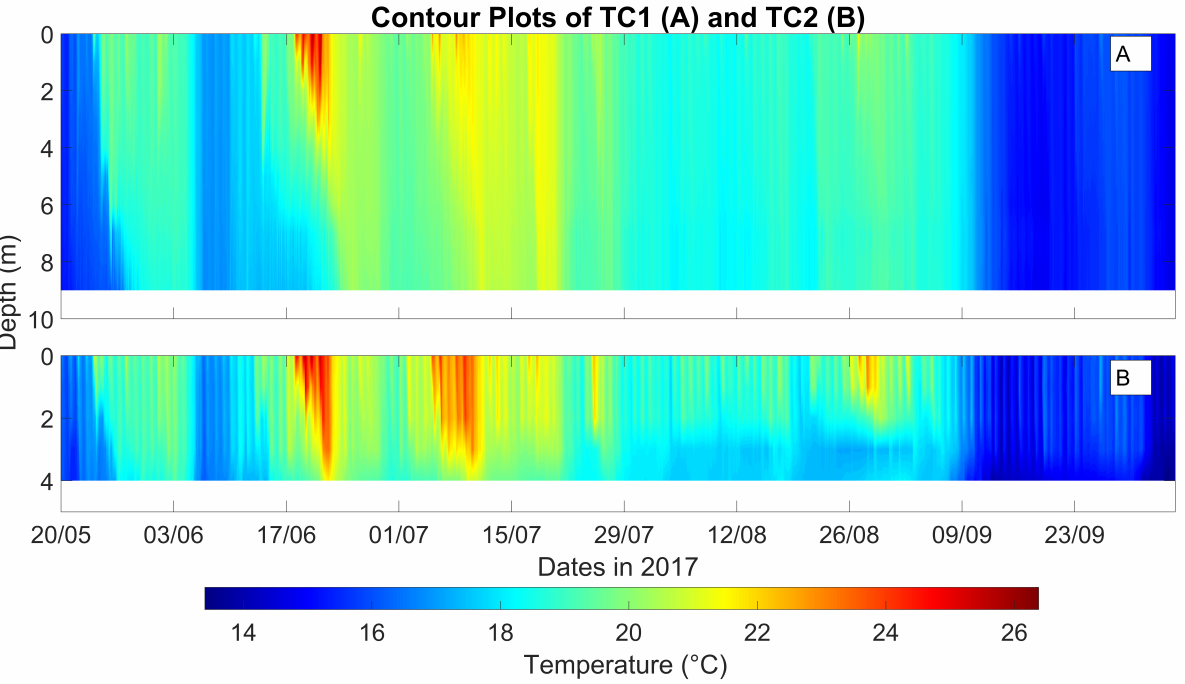
Figure 5. Contour plots of the observed data from temperature chain 1 (TC1) (panel A ) and temperature chain 2 (TC2) (panel B ); locations of these temperature chains shown in Figure 1. Temperature data were collected from the 20th of May to the 5th of October